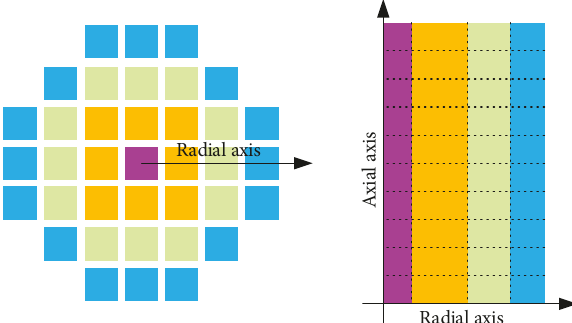
Figure 3: Nodalization picture of core fuel element